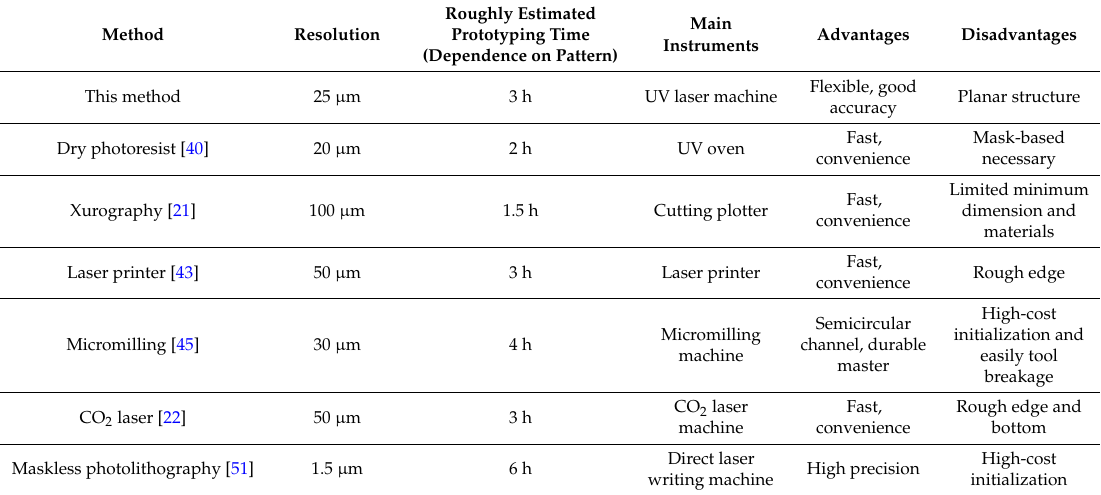
Table 5. The comparison of this method with other prototyping